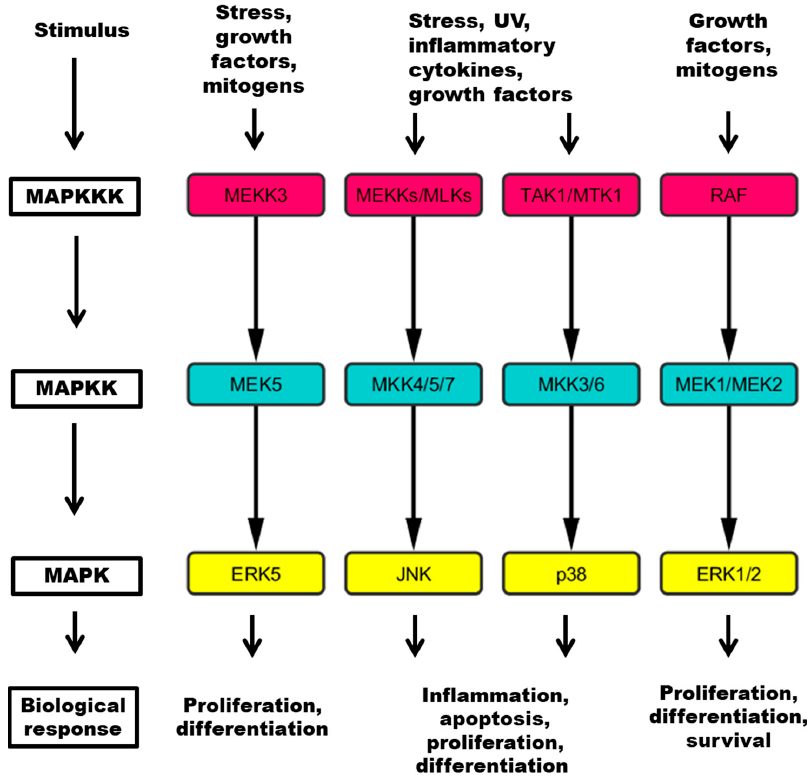
Figure 1. Four major pathways contain a three tiered kinase cascade comprising a MAP kinase kinase kinase (MAPKKK), a MAP kinase kinase (MAPKK) and the MAPK, which mediates responses to